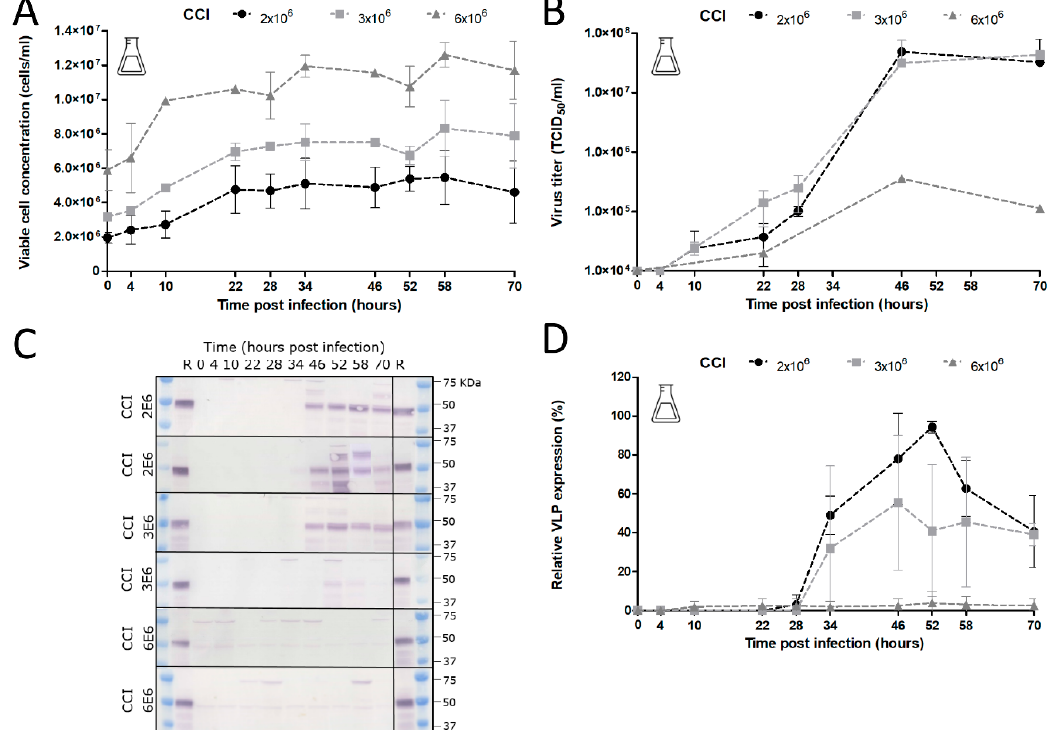
Figure 8. Effect of cell concentration at point of infection (CCI) on cell growth, baculovirus production and chikungunya VLP expression. ( A ) Cell growth after BACe56-CHIKV infection of Sf9 cells in shake flasks. Baculovirus infection was performed at MOI 0.01 TCID 50 /cell and different CCIs ranging from 2 × 10 6 till 6 × 10 6 cells/mL in shake flasks. Viral titers were determined by end point dilution assay and are expressed as tissue culture infective dose 50% per ml (TCID50/mL). Error bars are from duplicate experiments. ( B ) Baculovirus titers upon BACe56-CHIKV infection as function of CCI ( C ) CHIKV VLP expression determined by Western blot detection with anti-E2 polyclonal antiserum. R; reference VLPs. ( D ) Relative CHIKV VLP expression levels as function of CCI.